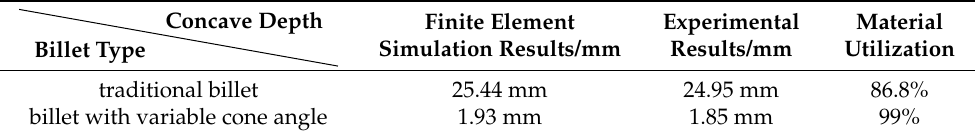
Figure 17. Comparison of Simulation ( a , c ) and Experimental ( b , d ) rolling effects of stepped shafts: ( a ) simulation results of rolling by a traditional billet; ( b ) experiment results of rolling by traditional billet; ( c ) simulation results of rolling by a billet with a variable cone angle; ( d ) experiment results of rolling by a billet with a variable cone angle. Table 2. Concave depth statistics of finite element simulation and experimental results of stepped shaft by cross-wedge rolling.